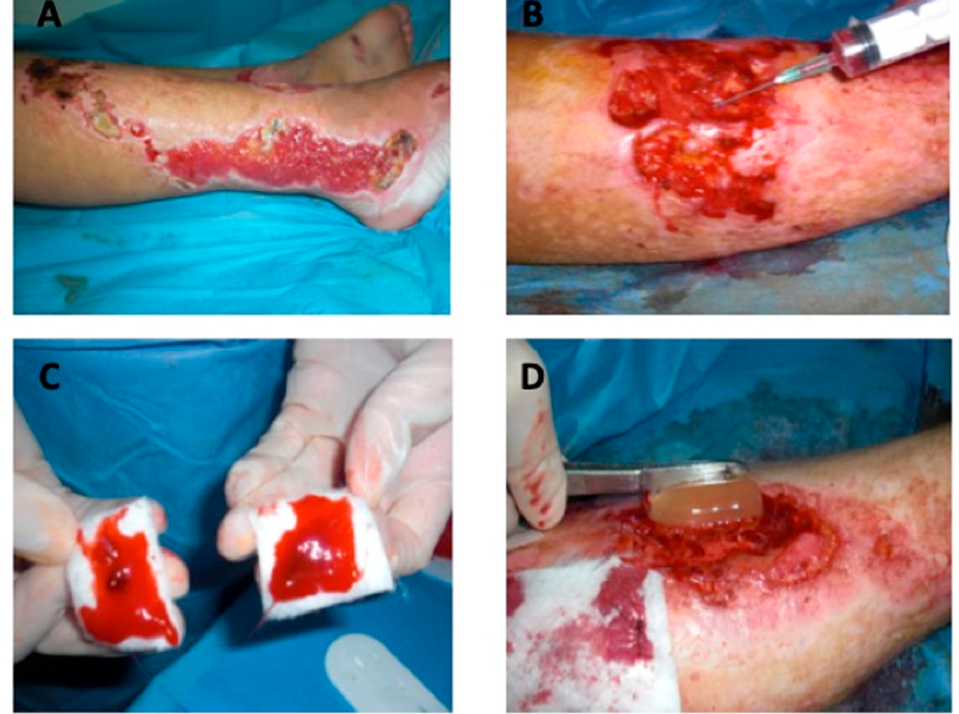
Figure 2. In vivo application of the bio-functionalized sca ff old: ( A ) Pre-surgical view; ( B ) Intra-lesional and peri-lesional injection of platelet-rich plasma (PRP); ( C ) PRP gel applied on hyaluronic acid (HA); ( D ) Hyaluronic acid sca ff old